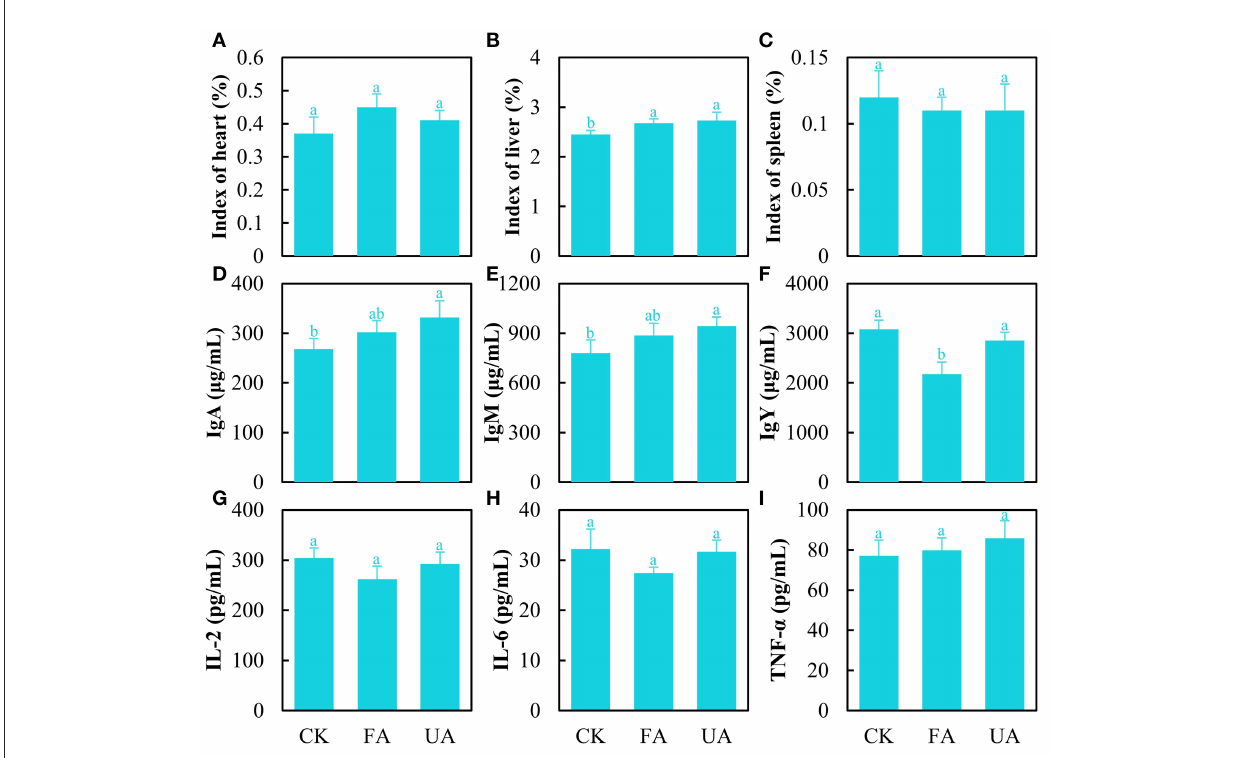
FIGURE5 Immunity of laying hens after feeding experiments, including heart index (A) , liver index (B) , spleen index (C) , content of IgA (D) , content of IgM (E) , content of IgY (F) , content of IL-2 (G) , content of IL-6 (H) , and content of TNF- α (I) (one-way ANOVA was performed to evaluate the difference). The same letter showed no significant difference between the chosen groups, while the different letters revealed that significant difference existed between the chosen